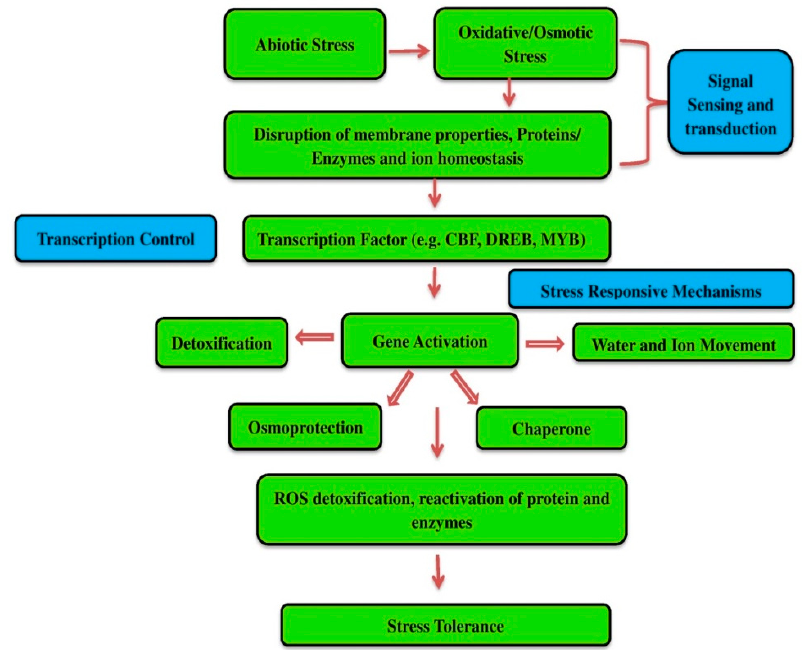
Figure 1. General scheme of Abiotic stress response and adaptation in plants.